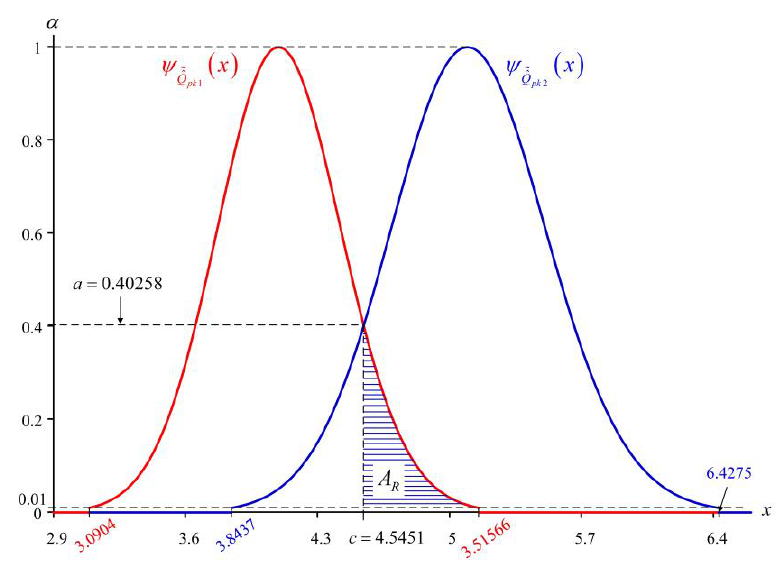
ˆ ˆ Q and Q for illustrative case. Figure 3. Relationship between fuzzy estimator (cid:101) ˆ Q pk 1 and (cid:101) ˆ Q pk 2 for illustrative 1 pk 2 pk